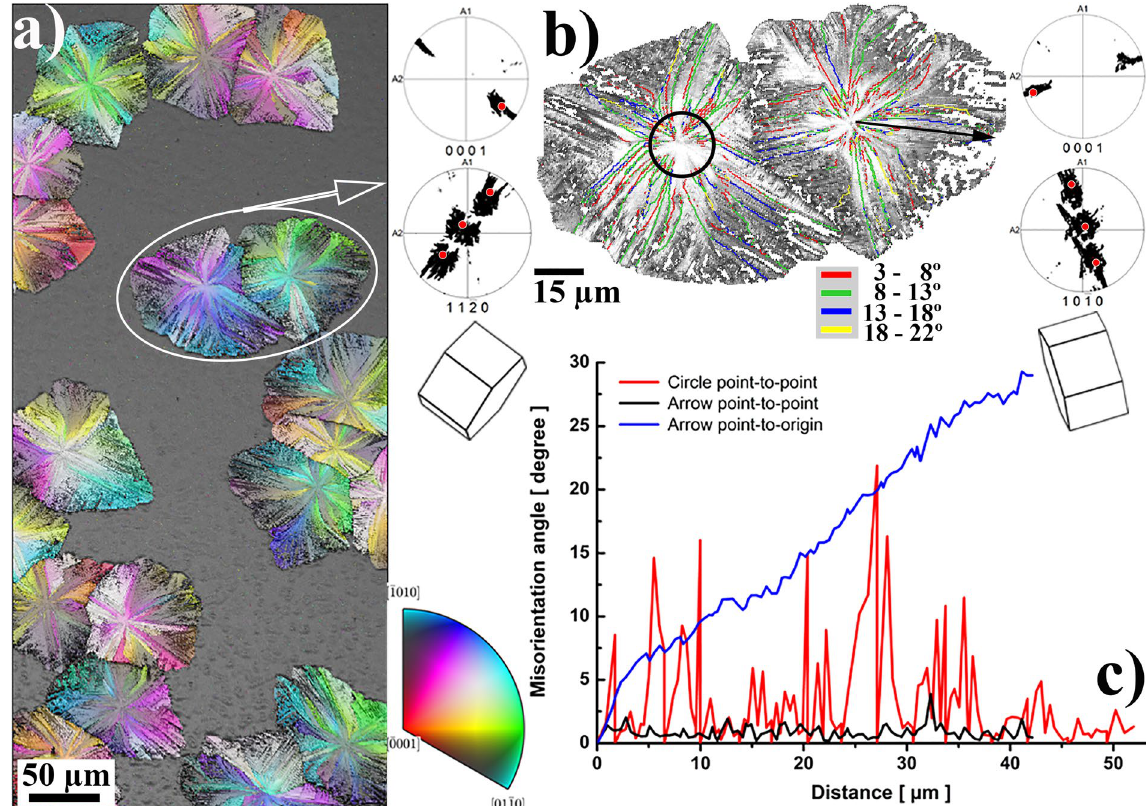
Figure 1. EBSD observations of spherulitic GeO 2 Quartz crystal islands. ( a ) IPF map (color) of crystal directions perpendicular to the thin film surface, combined with Image Quality (IQ) map (gray scale) from Zhou et al. 1 ; ( b ) the IQ map of two selected spherulites with misorientation boundaries added for orientation differences > 3°, marked by the corresponding colored lines. Side insets show the axonometric projections of crystal orientation at the center of these two spherulites, together with their corresponding (0001), ( 1120 ) and ( 1010 ) pole figures, on which orientations of the spherulite centers are marked by red points; ( c ) crystal misorientation angle profiles measured: (1) along the black circle around the center of the left spherulite on ( b ); (2) along the black arrow from the center to the edge of one fiber of the right spherulite on ( b ). The crystal direction color key is valid for the IPF map shown in ( a